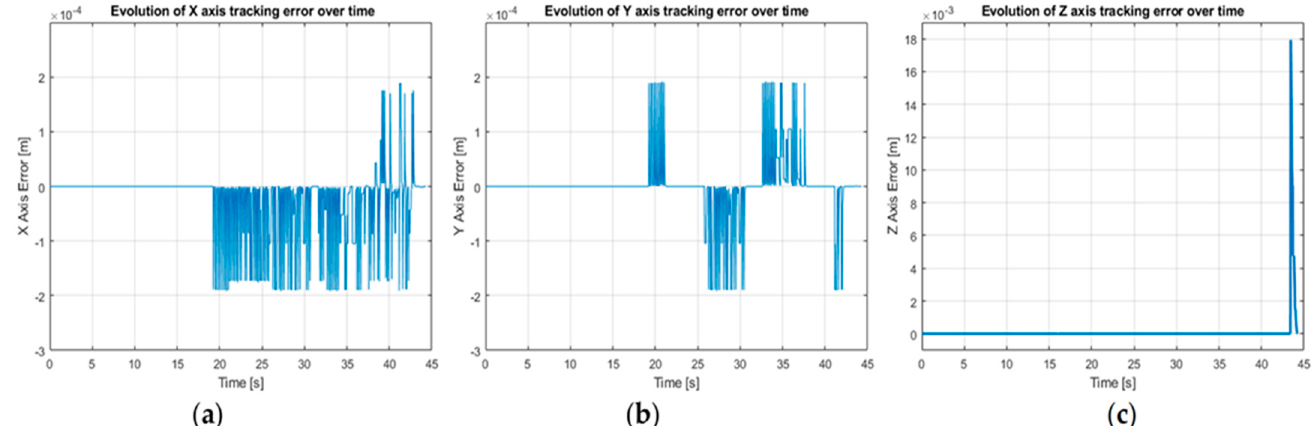
Figure 28. Tracking errors for RM Cyton placing object trajectory on: ( a ) X axis, ( b ) Y axis, and ( c ) Z axis.